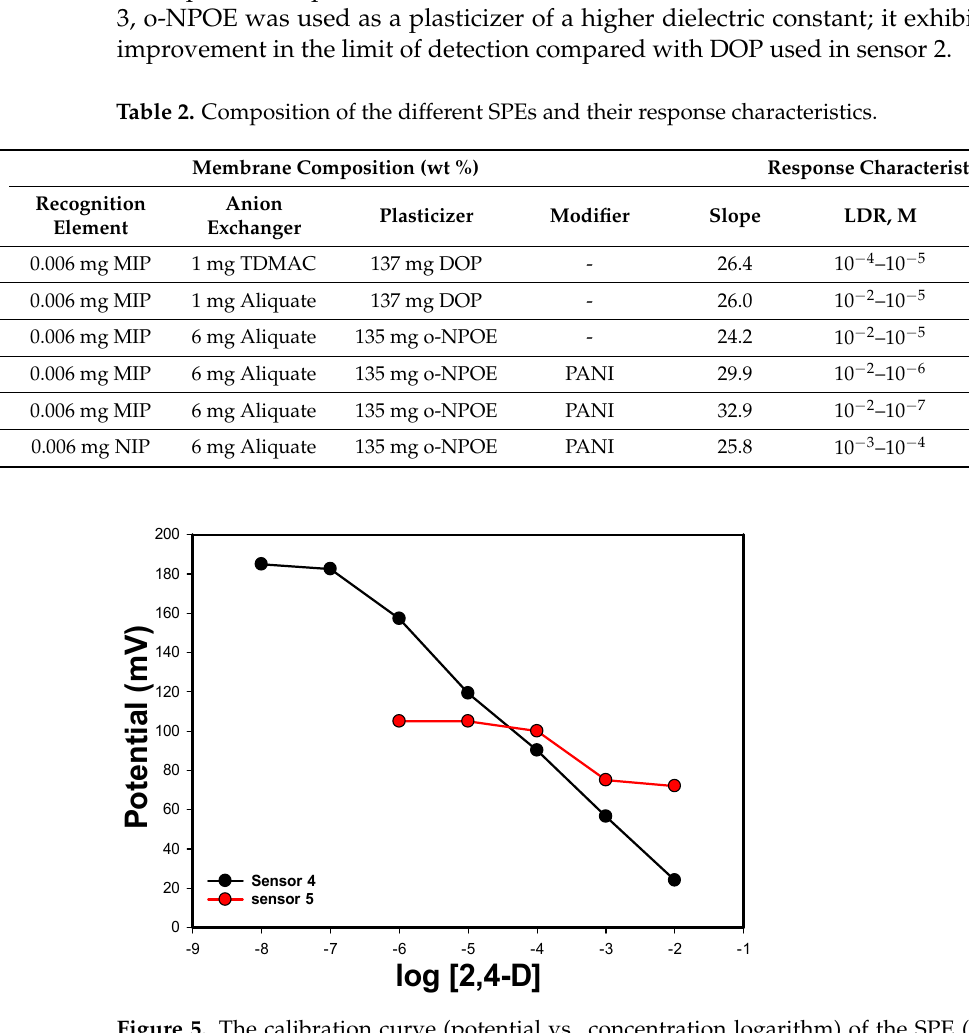
Figure 5. The calibration curve (potential vs. concentration logarithm) of the SPE (sensor 4 and sensor 5) coated with PANI conductive layers and measured in Tris buffer (pH = 7.0) at 25 °C.